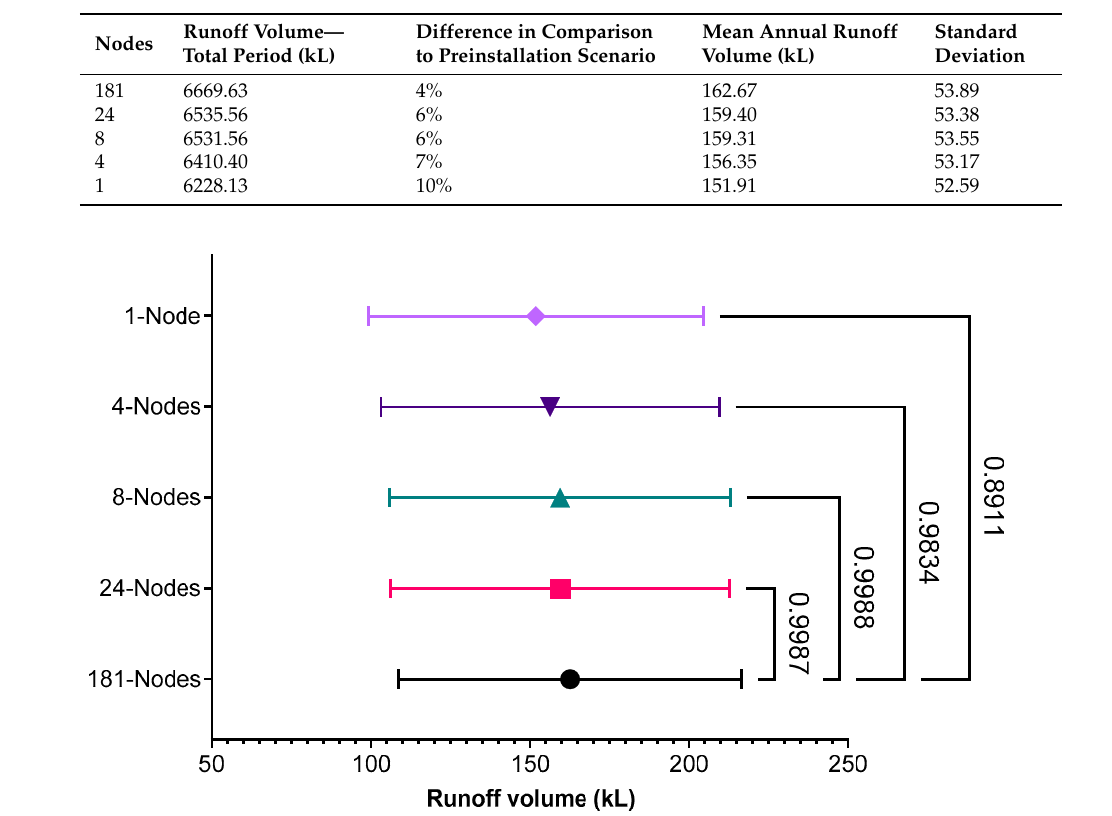
Table 6. The runoff volume produced with different levels of curbside leaky well aggregation.